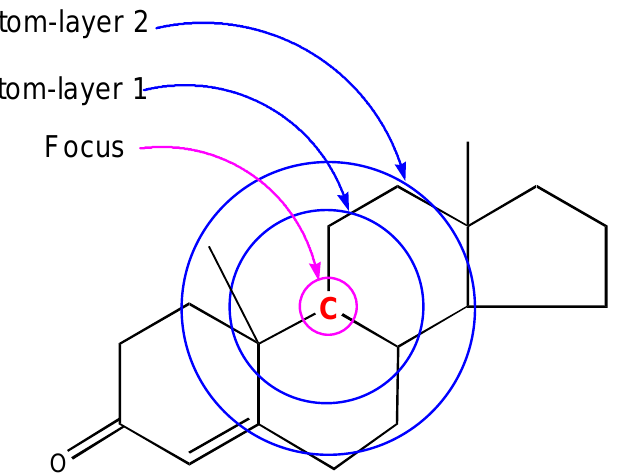
Figure 1. The center atom (focus atom) and atom layers in HOSE code approach.